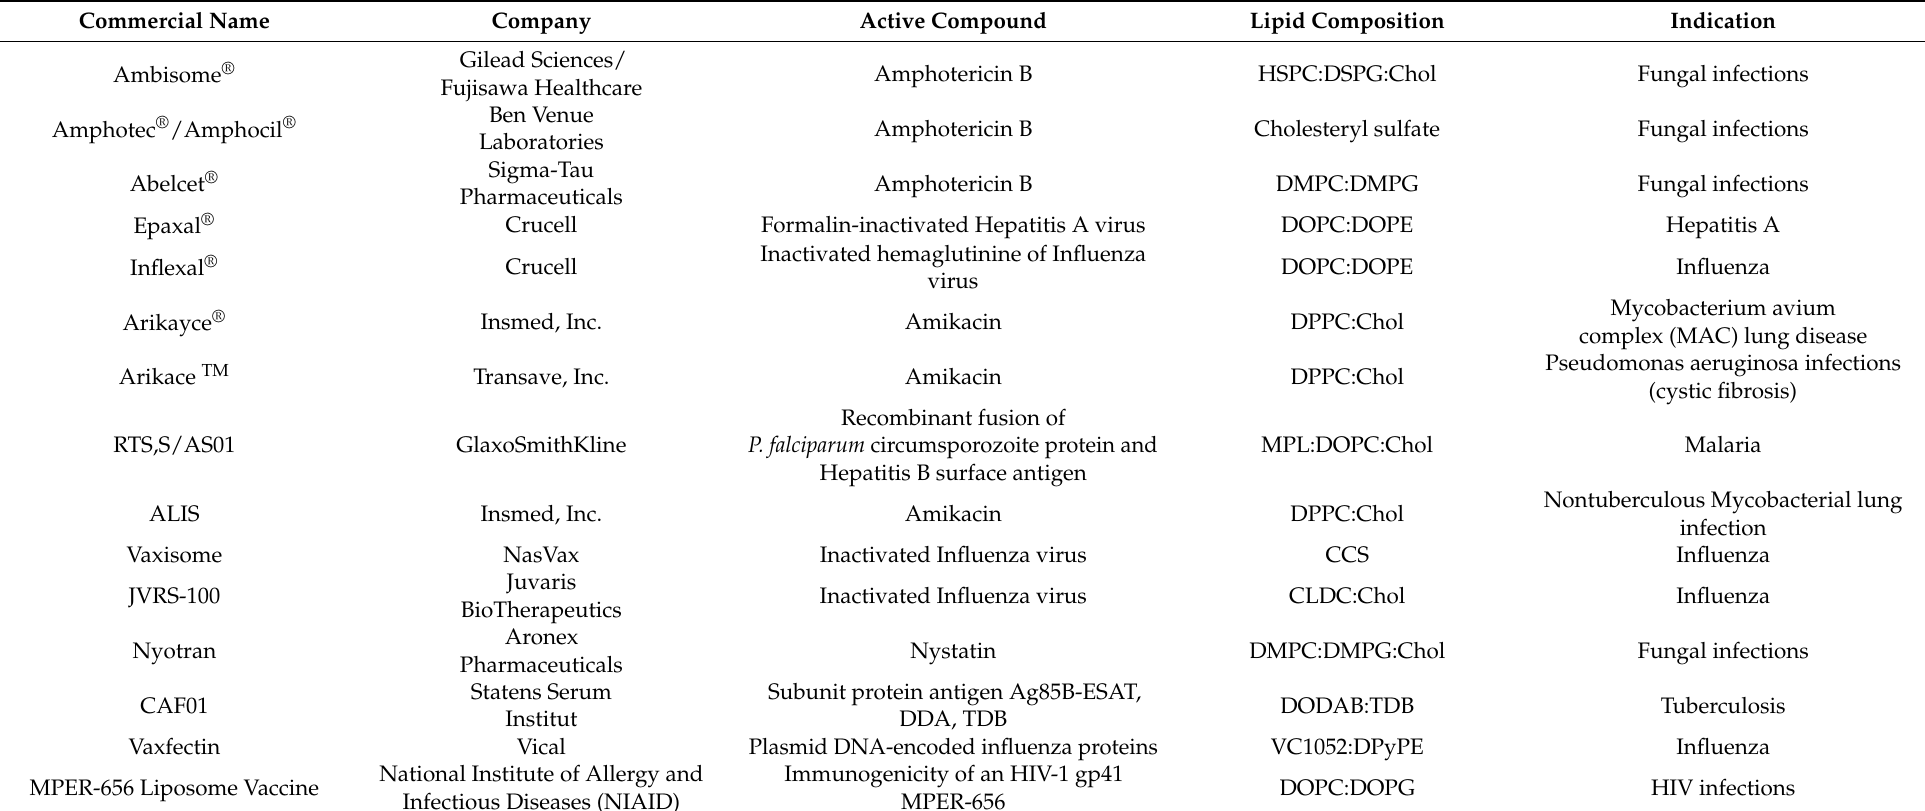
Table 1. Selected liposomal formulations and lipid-based vaccines FDA approved for human use or in clinical trials for the treatment of infectious